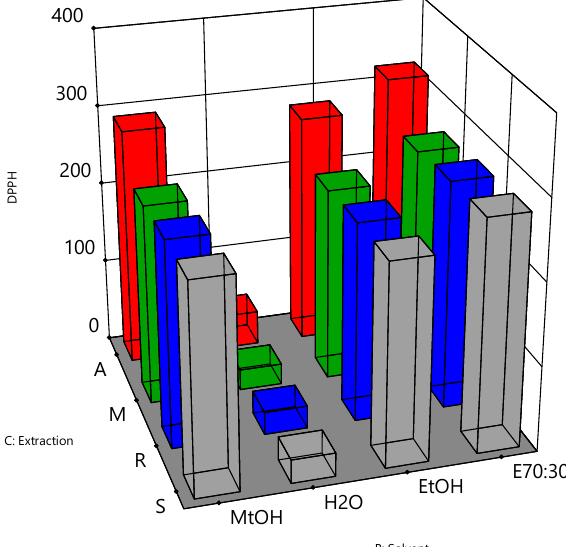
Figure 5. Effects of extraction solvent and extraction method on the DPPH antioxidant activity for bee pollen samples. DPPH values were expressed as μ mol Trolox equivalent per gram pollen, B: extraction solvent (70% ethanol:30% =E70:30, ethanol = EtOH, water = H 2 O, and methanol = MtOH) and C: extraction process (agitation = A, maceration = M, reflux = R, and sonication = S).